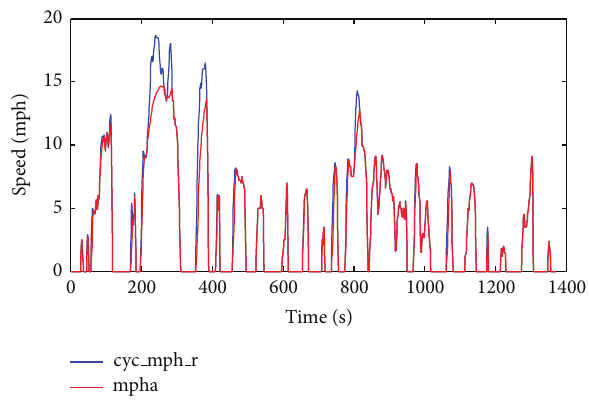
= 1 kW, the speed of simulation and drive cycle. Figure 12: 𝑃 motor